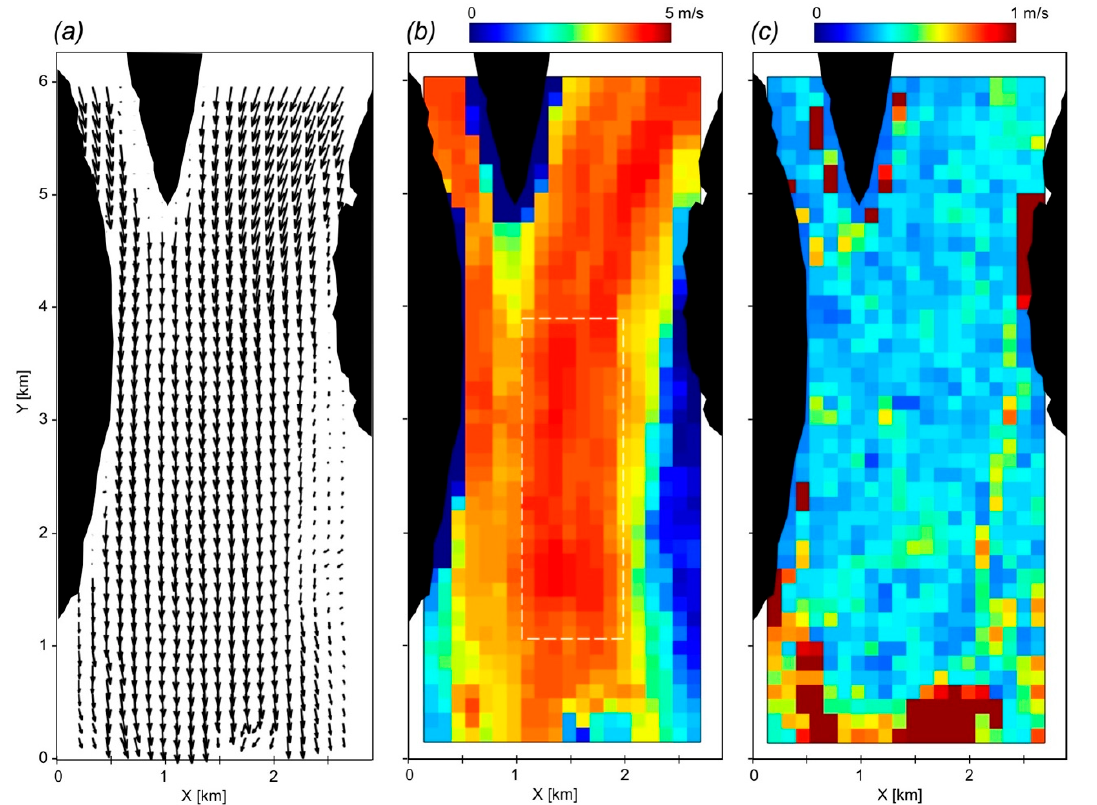
Figure 7. Ensemble-averaged result for mid-flood case: ( a ) Velocity vectors; ( b ) velocity magnitude; ( c ) root-mean-square values. The results derive from PIV analyses of eight consecutive image pairs (see Table 1, 22 August 2020).